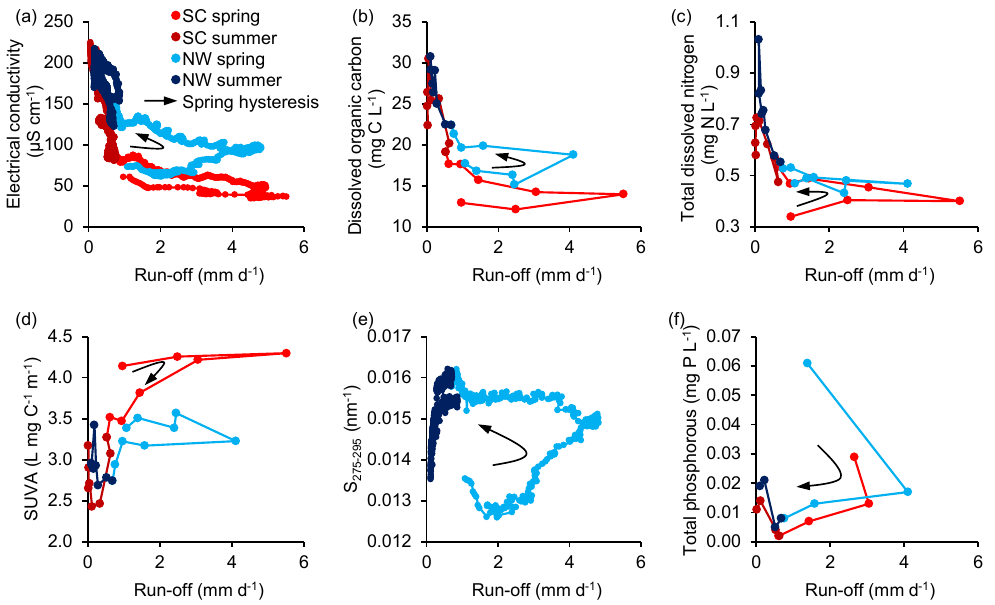
Figure 5. Relationships between run-off and (a) electrical conductivity, (b) DOC concentration, (c) total nitrogen, (d) SUVA, (e) S 275–295 , and (f) total phosphorous at Scotty Creek (SC) and Notawohka Creek (NW) outlets in 2016. Spring (29 April–26 May) and summer periods (27 May–9 September) are indicated, and direction of hysteresis during spring is shown by arrows.